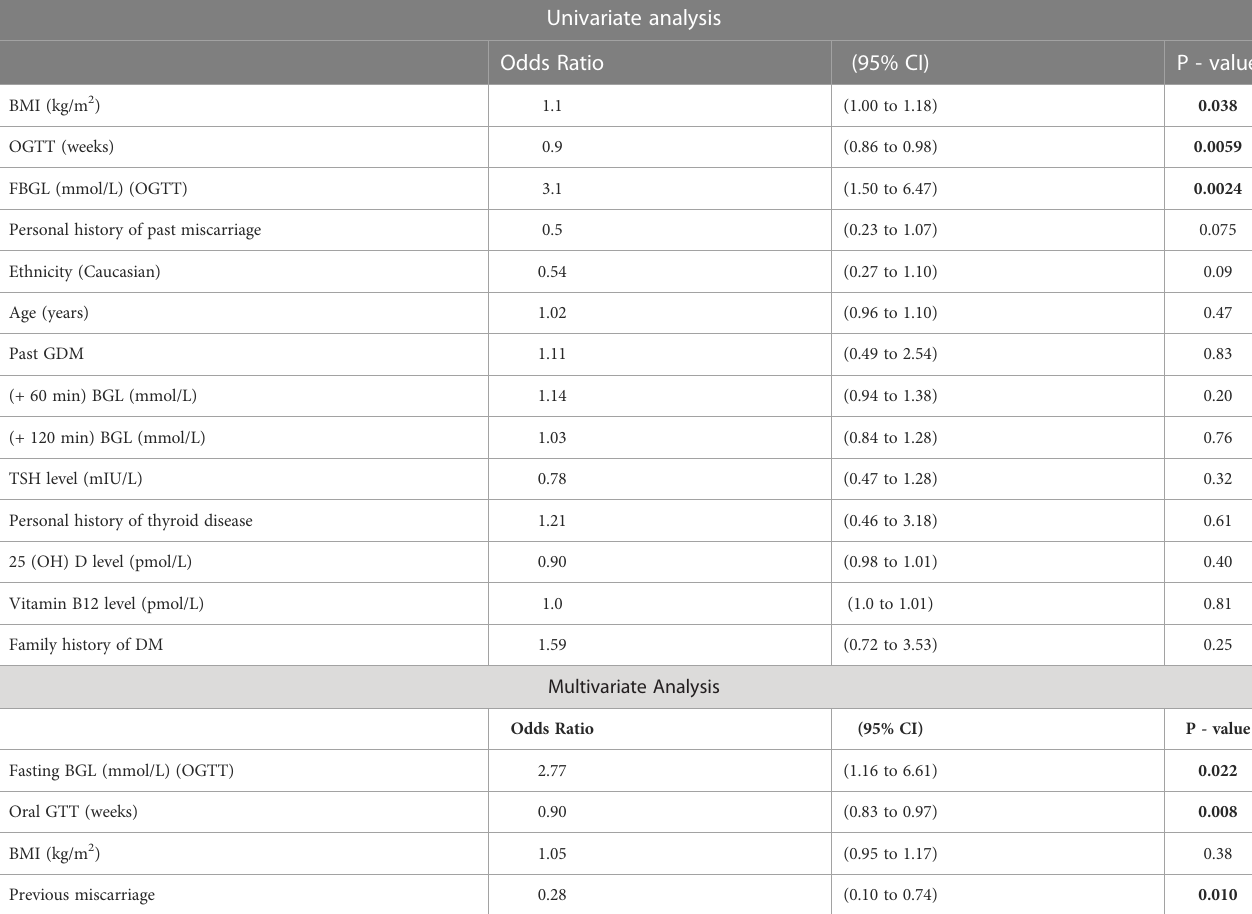
TABLE 4 Univariate and Multivariate analysis with predictors of pharmacological therapy in patients with gestational